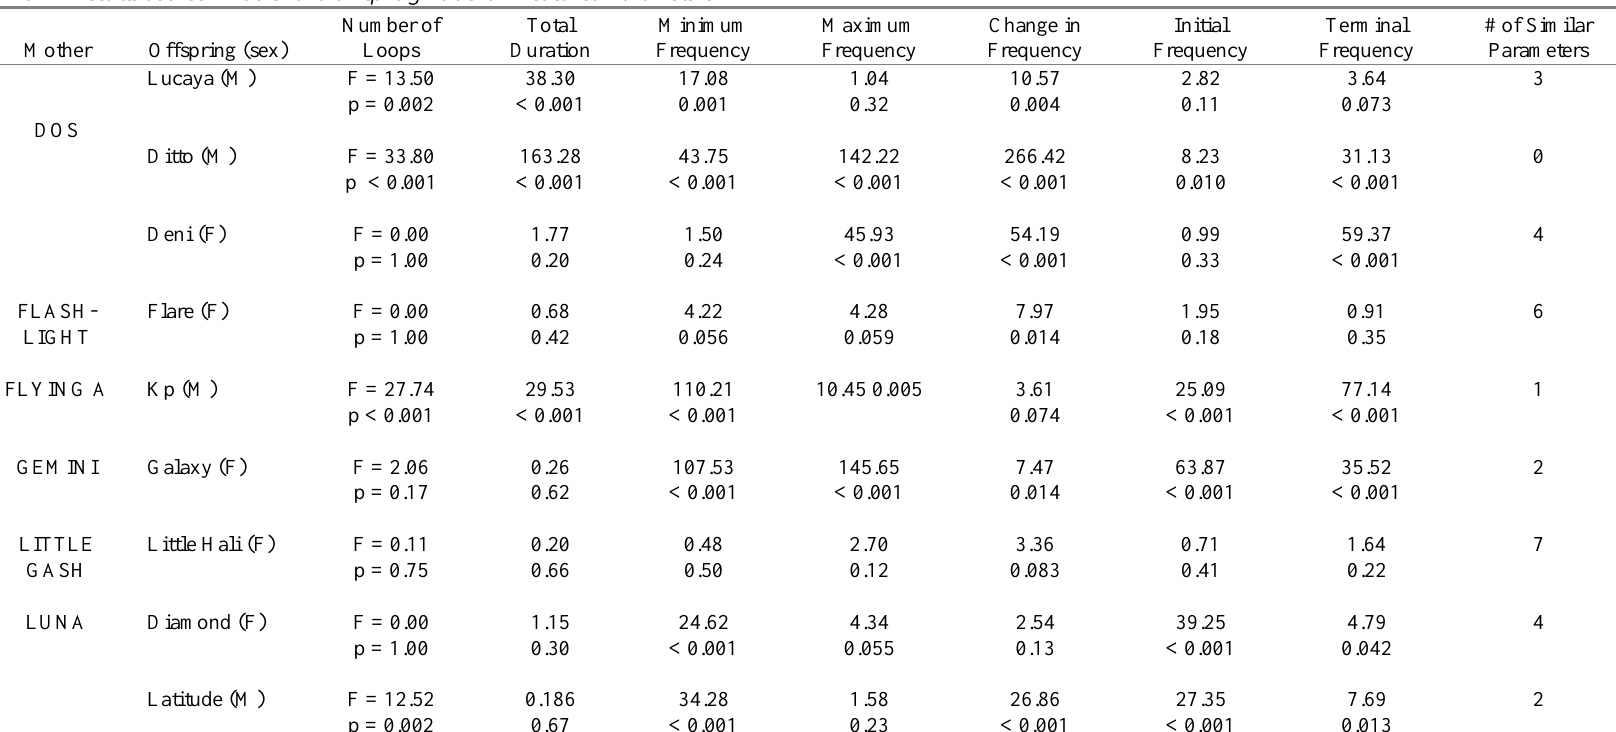
ANOVA Results between Mother and Offspring Pairs for Measured